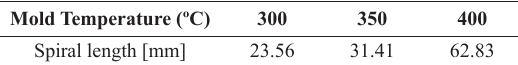
Figure 9. Production steps of the three-dimensional metal foam prototype started with the CAD model design (a); was followed by the production of the resin model in a stereolitography laser machine (b); and ended with the casted sample (c). Table 6. Spiral length metal filling with different initial mold temperatures.